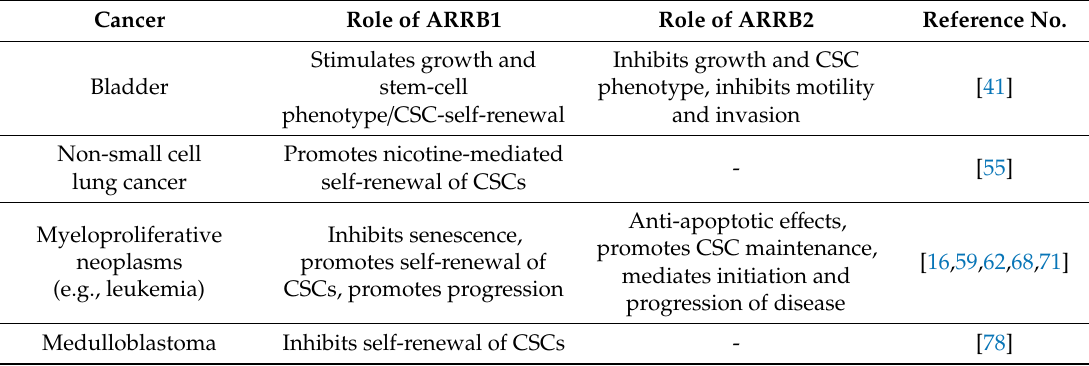
Table 1. The role of β -arrestins (ARRBs) in regulating cancer stem cells (CSCs). Cancer Role of ARRB1 Role of